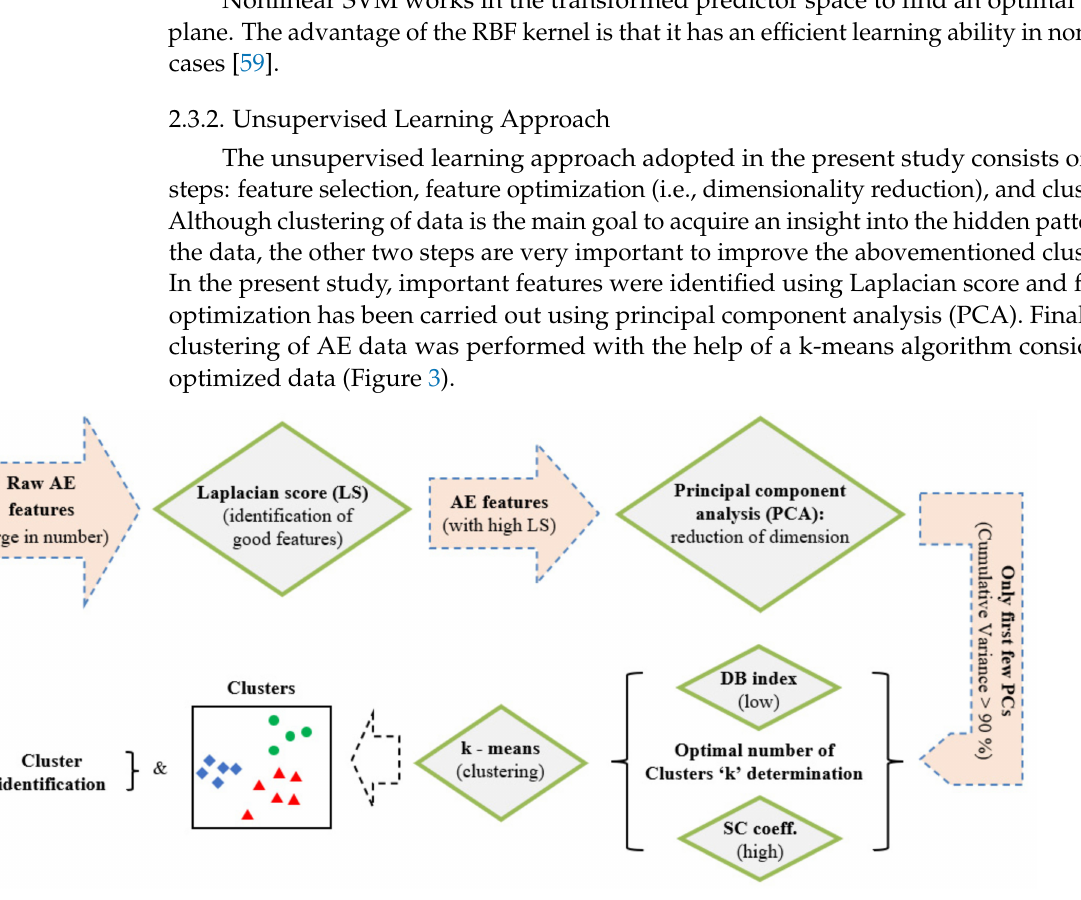
Figure 3. Flow chart showing steps involved in the adopted unsupervised learning